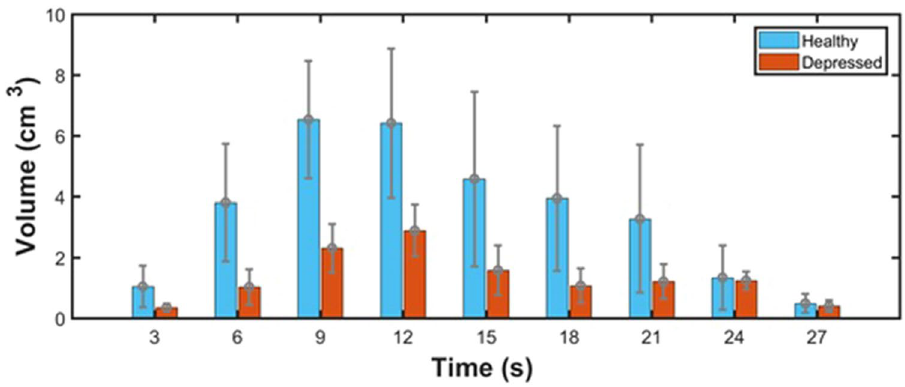
Figure 6. Averaged volume change (in cm 3 ) with error bars of [HbO] signal compared between the healthy and depressed